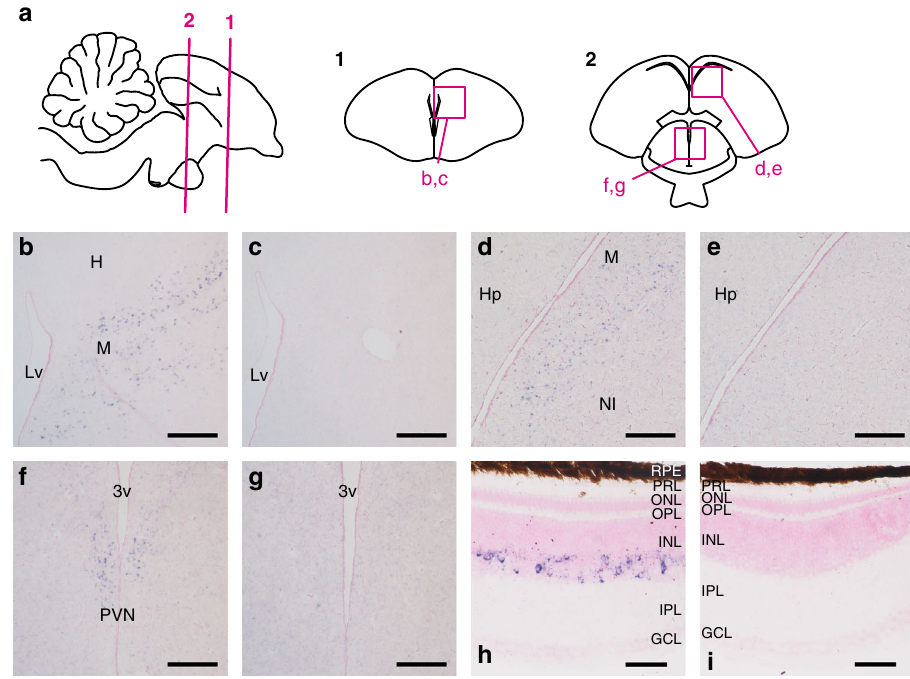
Fig. 5 Distribution of Opn5L1 mRNA in chicken brain and retina. a Schematic drawings of chicken brain to show the approximate positions of frontal sections. Numbered lines in sagittal drawing indicate the positions of frontal sections numbered 1 and 2. Magenta boxes show the areas of panels b − g . b − g Opn5L1 mRNA in the chicken brain. Sections were hybridized with Opn5L1 antisense ( b , d , f ) and sense ( c , e , g ) probes. Panels ( c ), ( e ), and ( g ) show the tissue sections consecutive to ( b ), ( d ), and ( f ), respectively. h , i Opn5L1 mRNA in the chicken retina. Sections were hybridized with Opn5L1 antisense ( h ) and sense ( i ) probes. All the sections were counterstained with Nuclear Fast Red. Scale bars: b − g 300 μ m; h , i 50 μ m. Lv lateral ventricle, H hyperpallium, M mesopallium, Hp hippocampus, NI intermediate nidopallium, 3v third ventricle, PVN paraventricular nucleus, RPE retinal pigment epithelium, PRL photoreceptor layer, ONL outer nuclear layer, OPL outer plexiform layer, INL inner nuclear layer, IPL inner plexiform layer, GCL ganglion cell layer